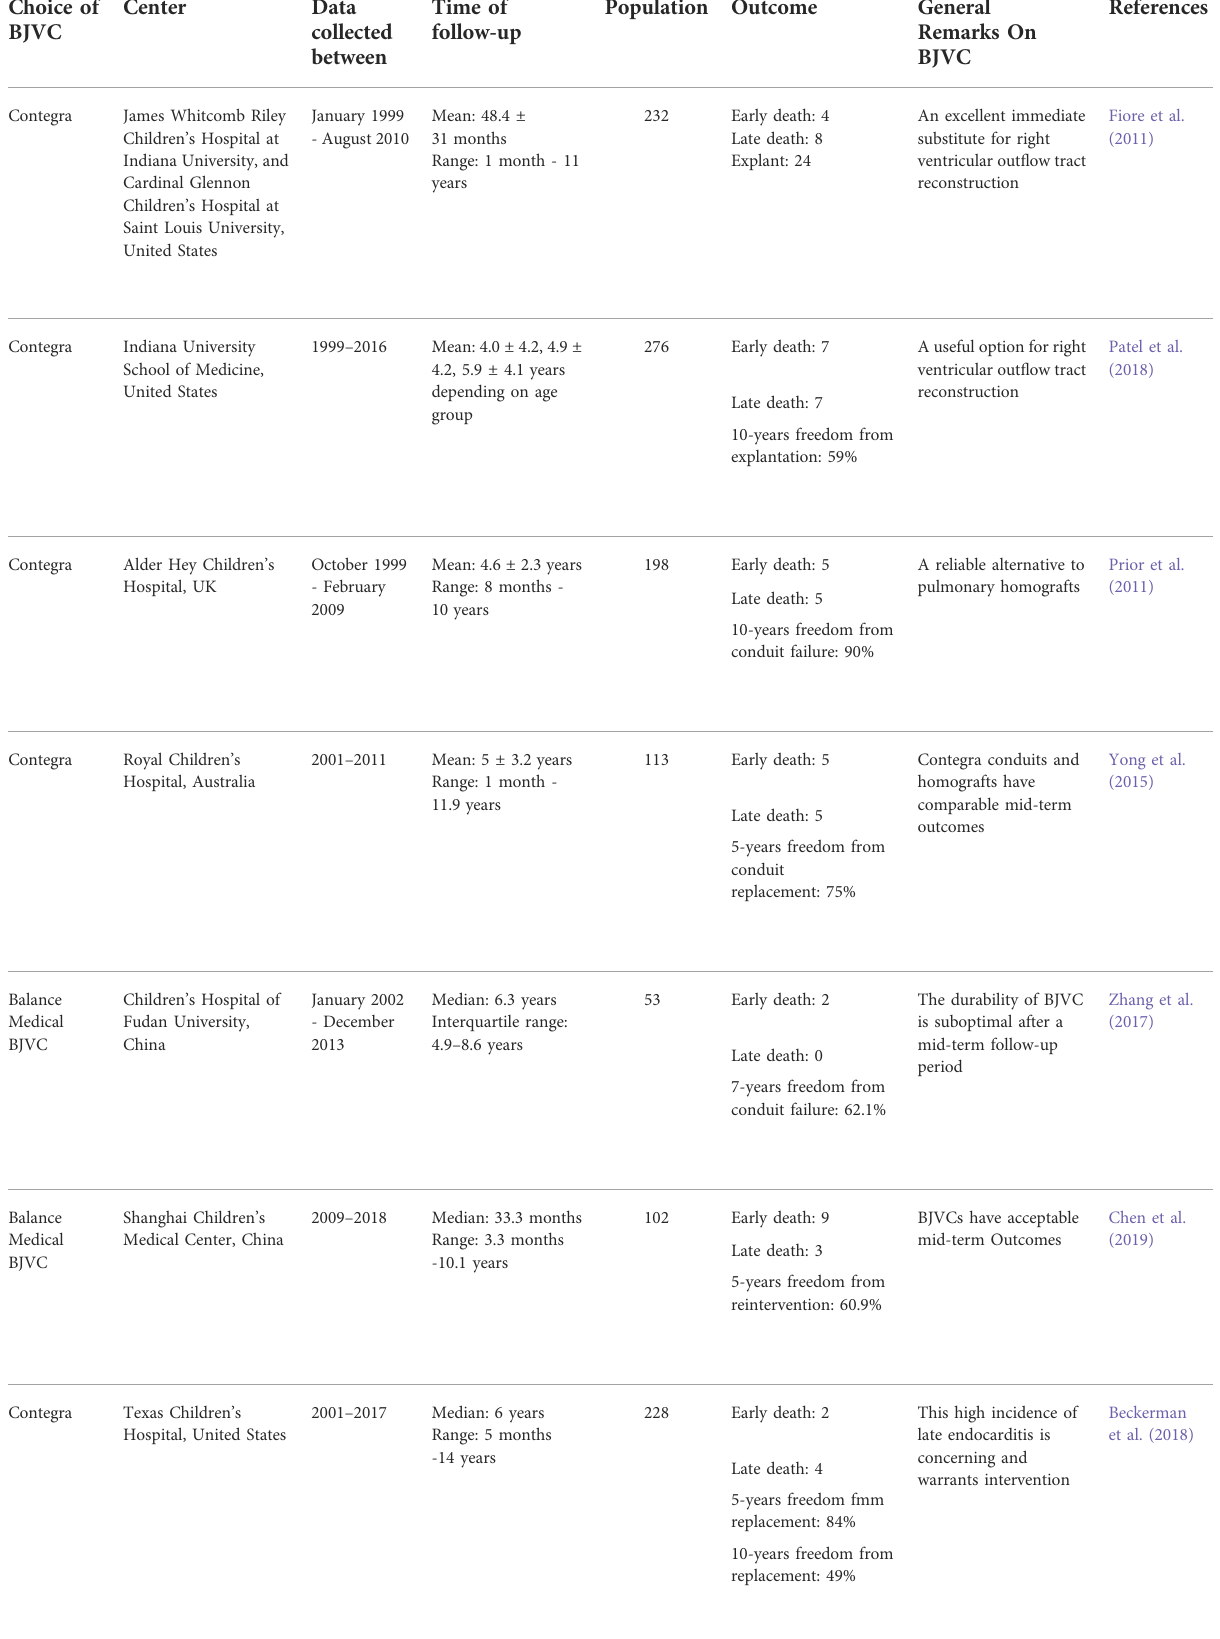
TABLE 1 Clinical studies on bovine jugular vein conduits for right ventricular out fl ow tract reconstruction. Time of Choice of Center Data BJVC collected between